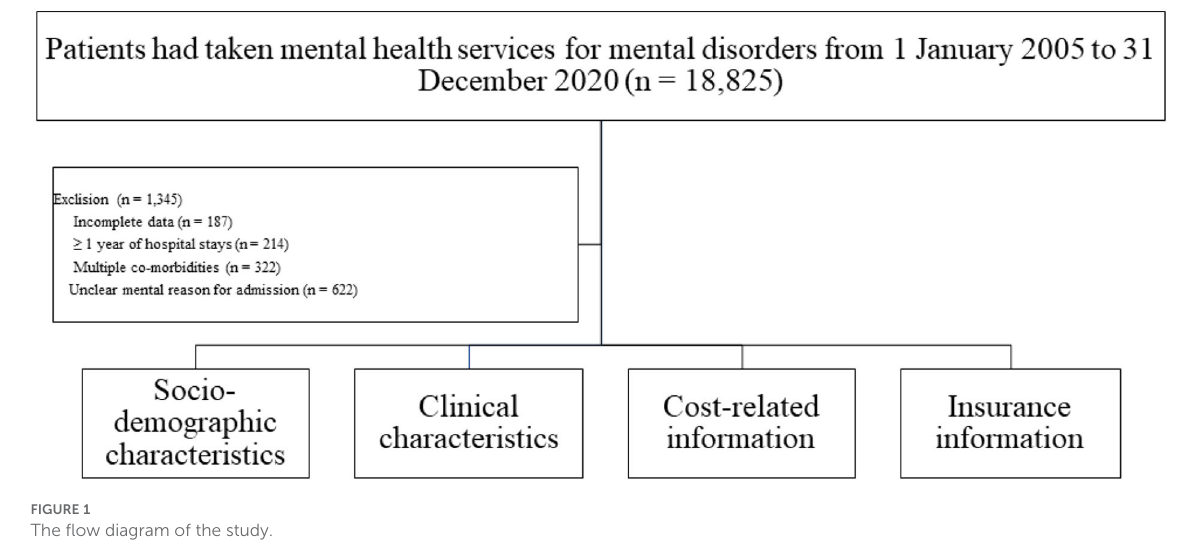
FIGURE1 The flow diagram of the study.